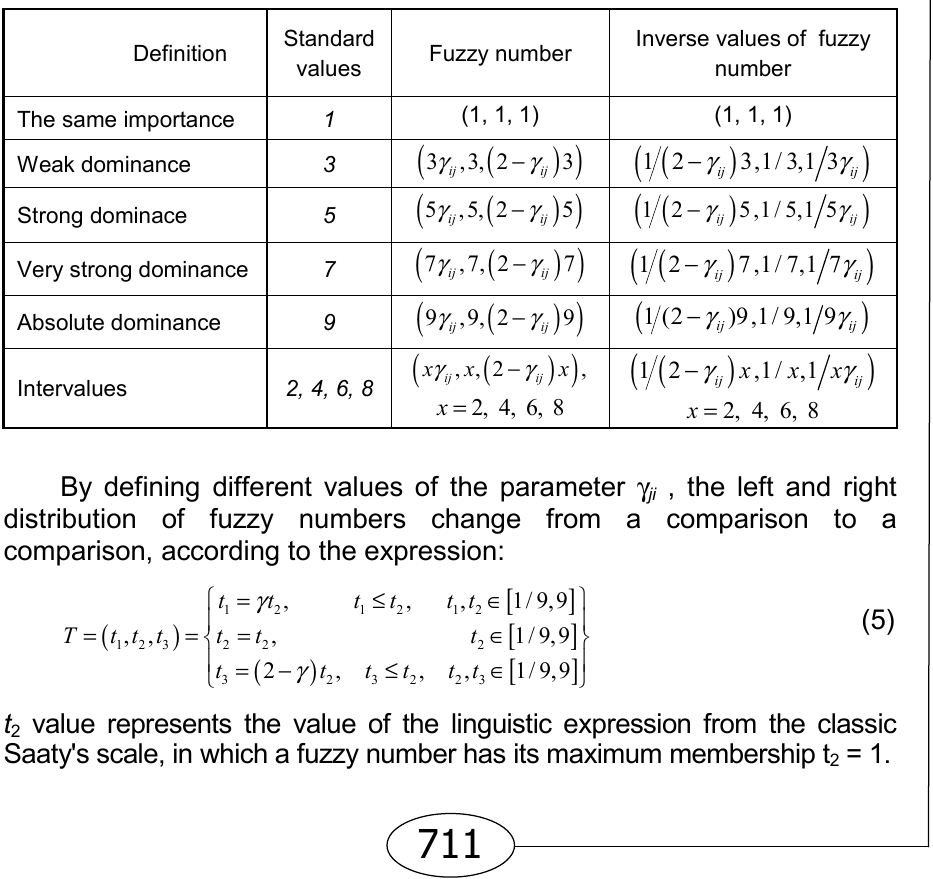
Table 2 – Fuzzified Saaty's scale for a comparison in pairs (Božani ć , Pamu č ar), (Božani ć , et al. 2015b) Таблица 2 – Фаззифицированная шкала Саати для парного